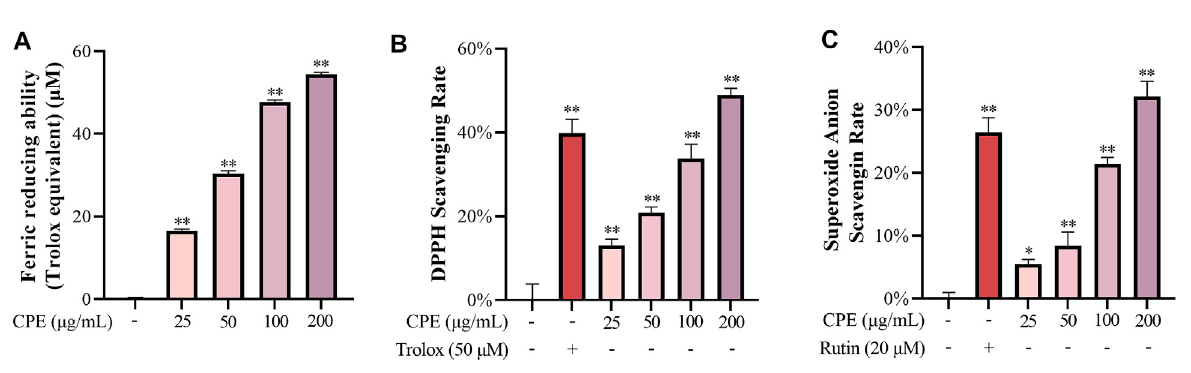
FIGURE 3 Ferric reducing ability (A) , DPPH scavenging activity (B) , and superoxide anion scavenging activity (C) of CPE ( n = 3). Ferric reducing ability was expressedasTrolox( μ M)equivalentantioxidantcapacity. Troloxandrutin wereusedaspositive controlsforDPPHandsuperoxideanionscavenging activity, respectively. * p < 0.05 and ** p < 0.01 vs. normal control